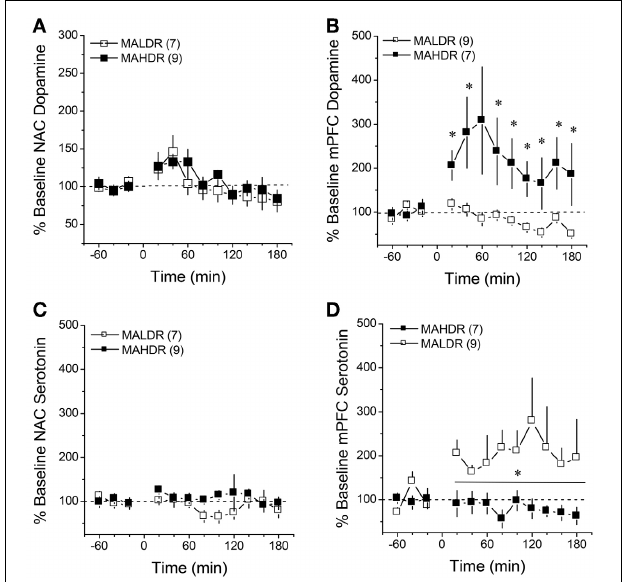
FIGURE 7 | Summary of the change in extracellular dopamine (A,B) 1 . 49 ± 0 . 22(11) and serotonin (C,D) exhibited within the NAC core-shell interface (left) and mPFC (right) of genetically heterogeneous B6 × D2 mice (F2B6D2) and mice selectively bred for high vs. low MA intake (MAHDR and MALDR, respectively) administered an acute injection of 2mg/kg MA. The data are expressed as a percent change from the average baseline values and represent the means ± s.e.m’s of the number of animals indicated in parentheses in each panel. ∗ p < 0 . 05 vs. average baseline.